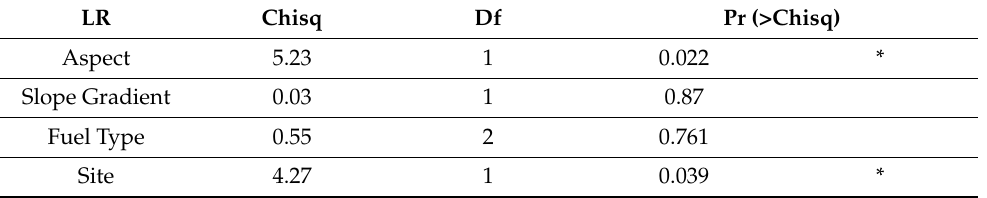
Table 5. Type III sums of squares ANOVA results for a full model with burn severity classes (unburned, low, moderate, and high) as response, and aspect, slope, fuel type, and burn scar site as explanatory variables. * indicates significant p -value of less than 0.05. LR Chisq Df Pr